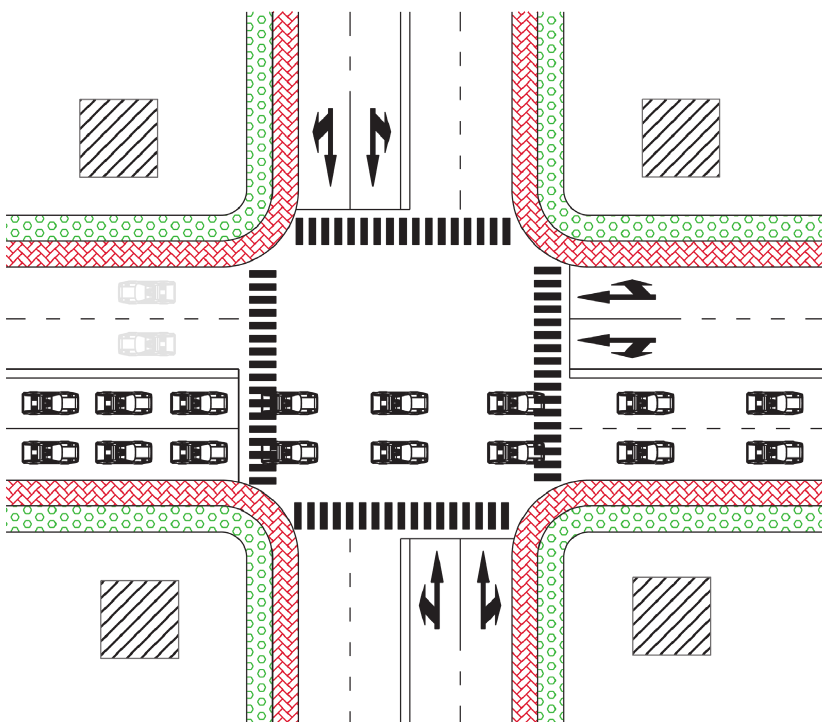
Figure 3: Traffic density at the